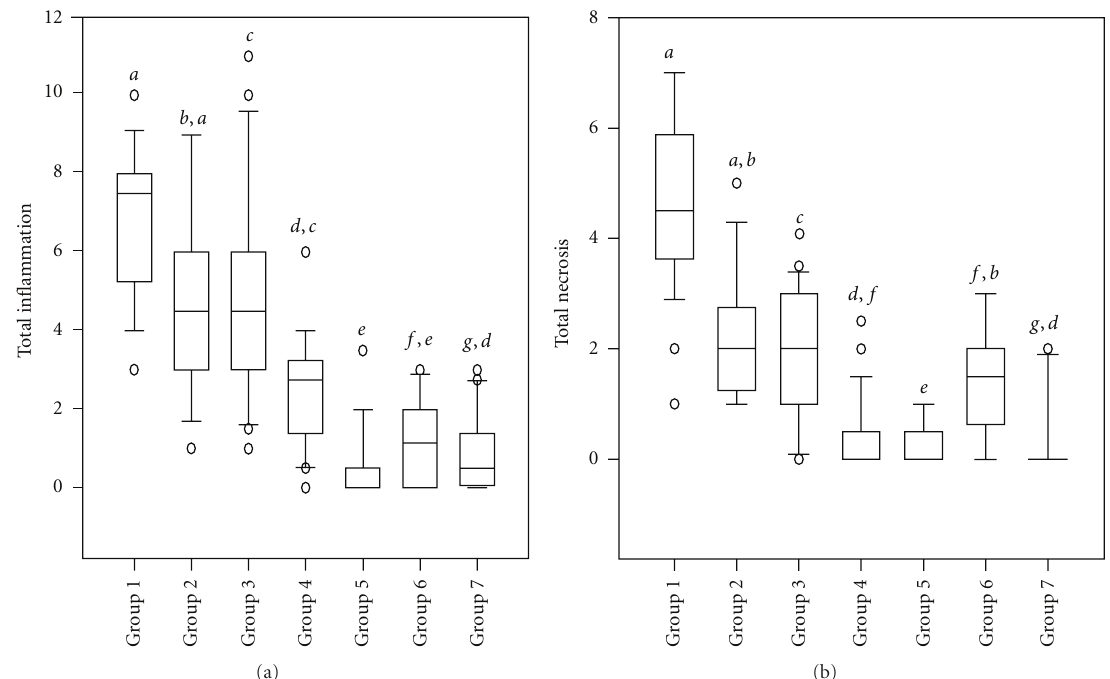
Figure 3: The box plots of all seven groups of Atlantic salmon on the basis of (a) total inflammation and (b) total necrosis in the heart and skeletal muscle ( N = 173). Group 1 ( n = 28) and group 2 ( n = 16) represented fish from an acute and late phase of a HSMI outbreak, respectively, while group 3 ( n = 31) represented values from fish from an early phase of HSMI, and group 4 ( n = 30) included chronic CMS fish. Group 5 ( n = 28), group 6 ( n = 20), and group 7 ( n = 20) represented values from nondiseased (non-HSMI) fish. Higher scores of inflammation and necrosis were found in diseased (groups 1, 2, 3, and 4) fish while low levels of scores in nondiseased (groups 5, 6, and 7) fish were present. Bars with di ff erent letters represented significant di ff erences between groups ( P < 0 . 05). ( ◦ ) denotes outliers.